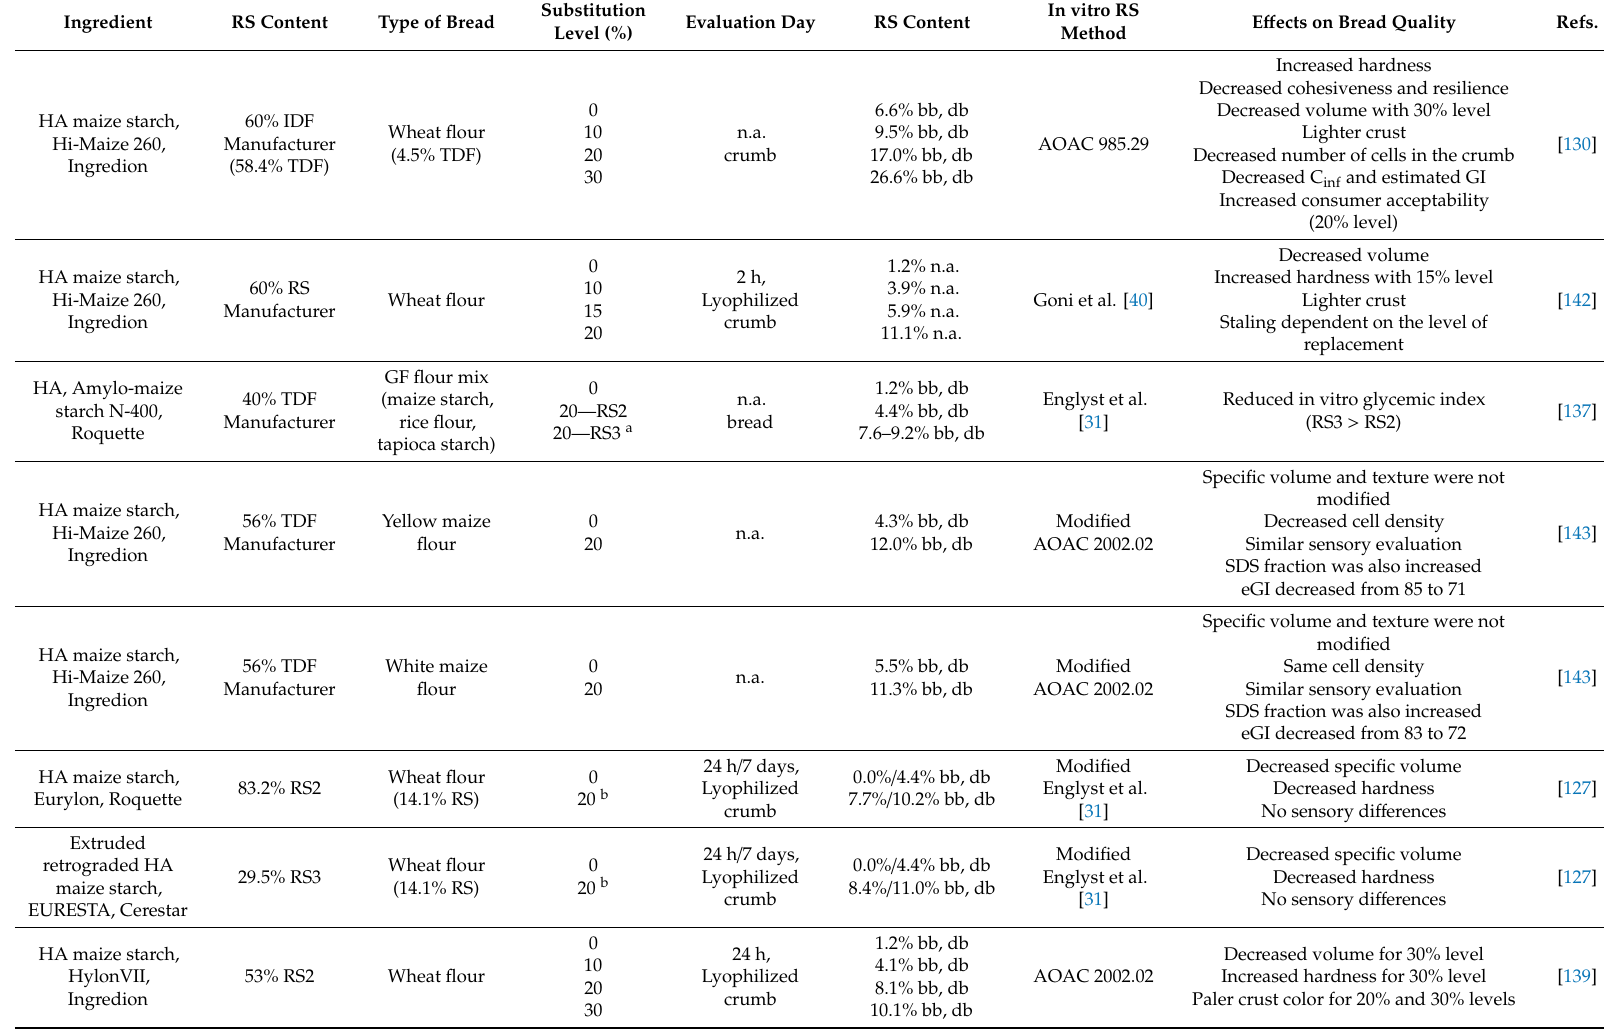
Table 2. In vitro studies on commercially available RS2 and RS3 sources as ingredients to increase RS content in wheat- and gluten-free breads. Ingredient RS Content Evaluation Day RS Content